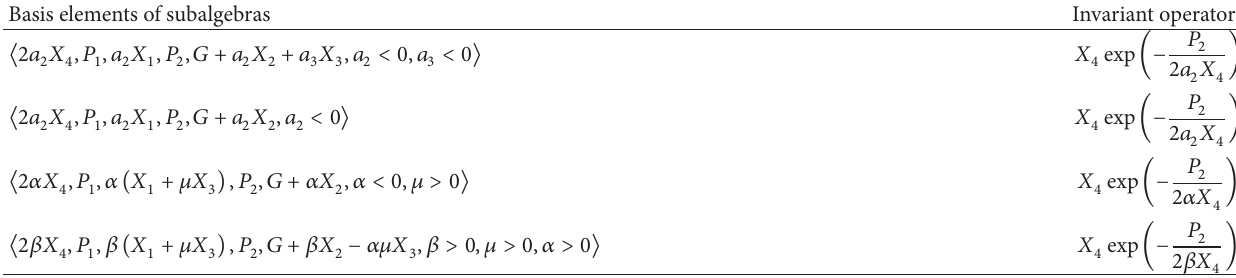
Table 26: Invariant operators of subalgebras of the type 𝐴 𝑎 5,20 (𝑎 = 1) . Basis elements of subalgebras